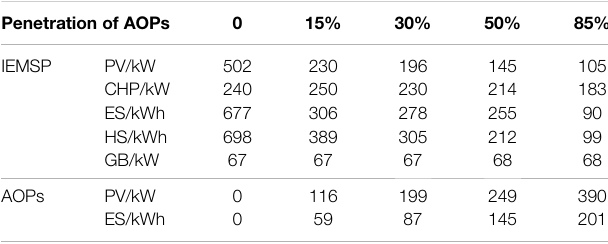
TABLE 3 | Capacity allocation results of different penetrations of AOPs. Penetration of AOPs